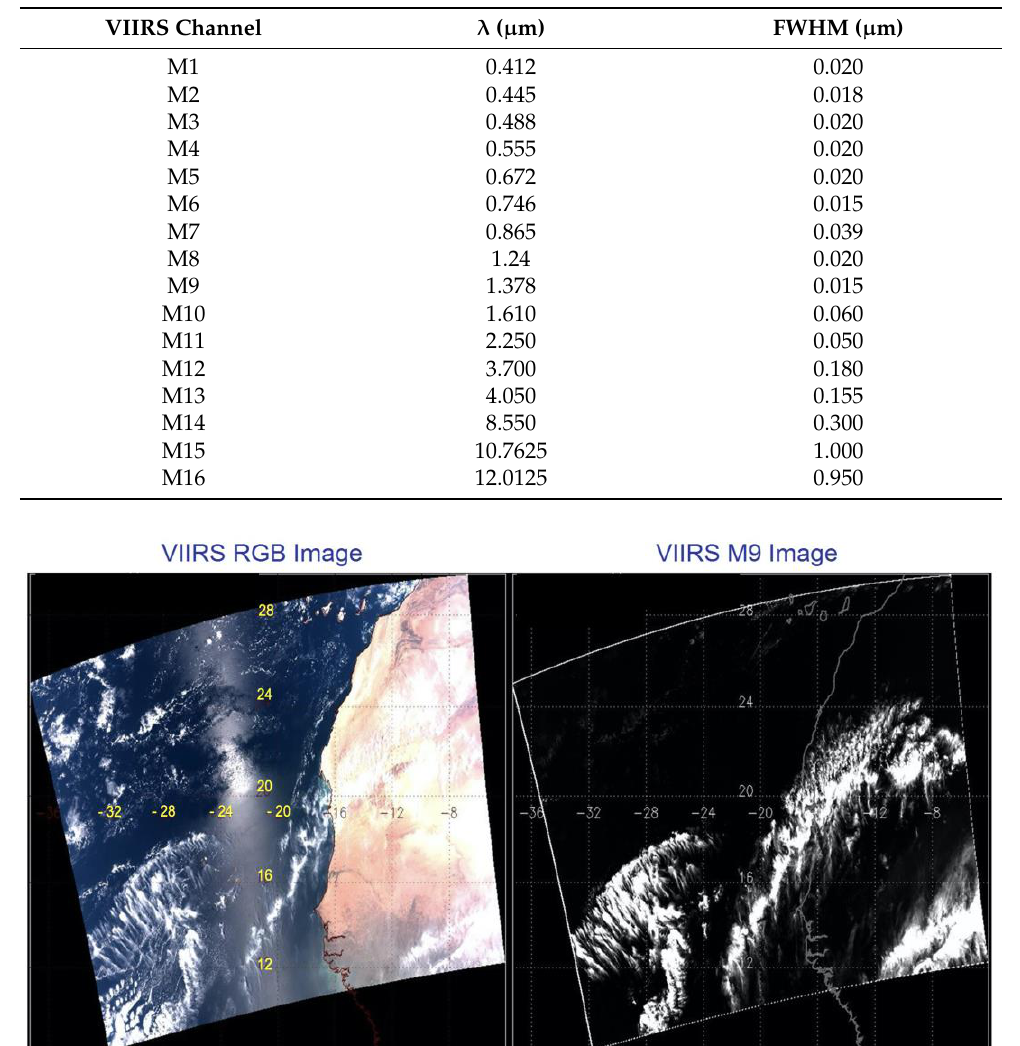
Table 1. VIIRS channel names, positions, and full widths at half maximum (FWHMs).